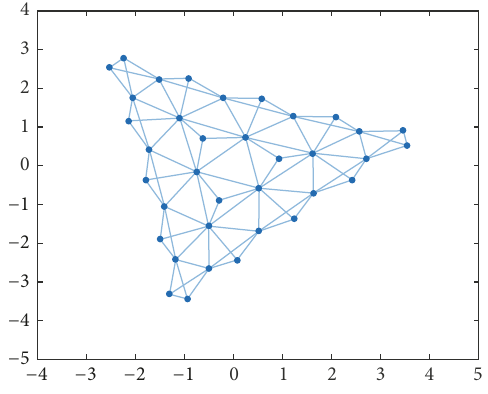
Figure 9: Triangular silicate network